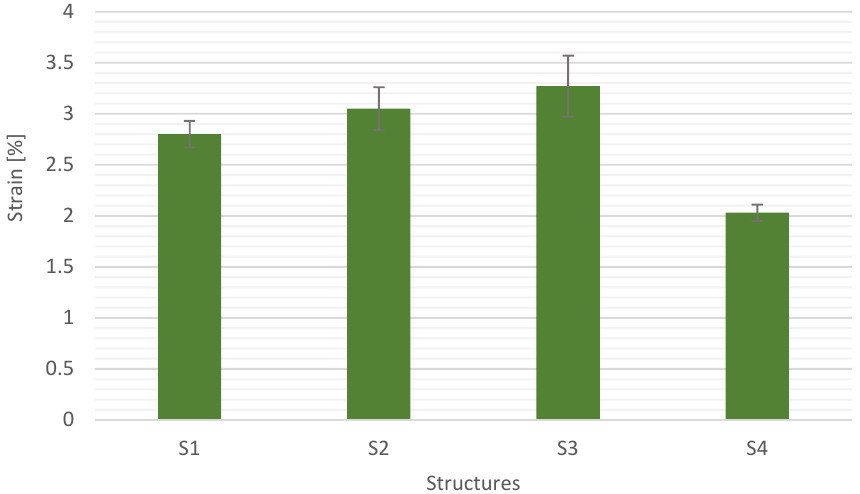
Figure 13. Flexural modulus different composite structures.